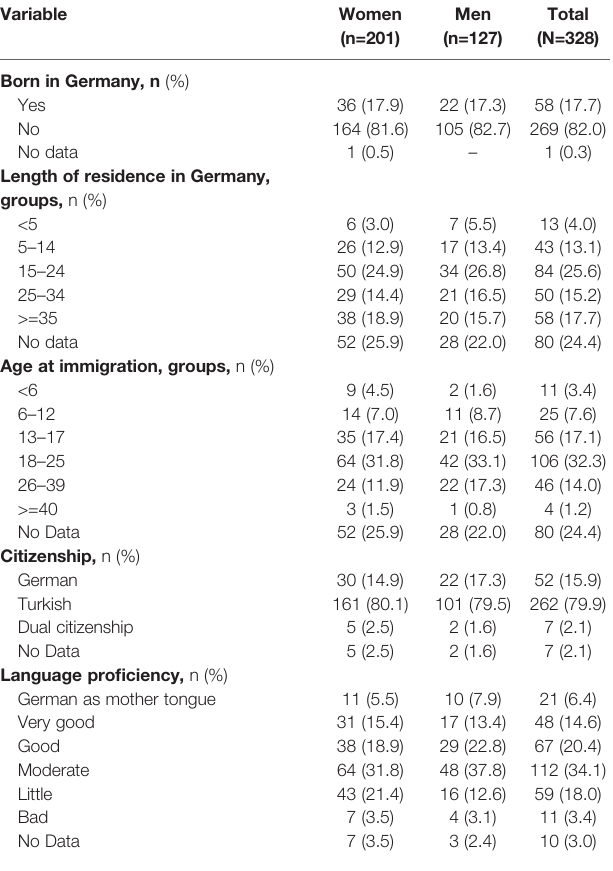
TABLE 2 | Migration-related characteristics of female and male migrants of Turkish origin and the total sample.